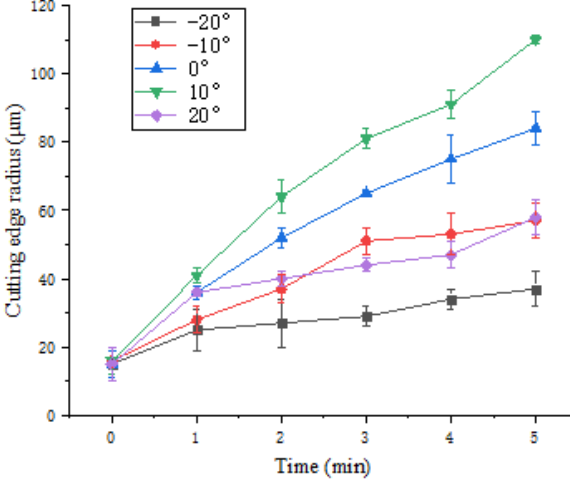
Figure 7. Experimental results under different polishing angles.